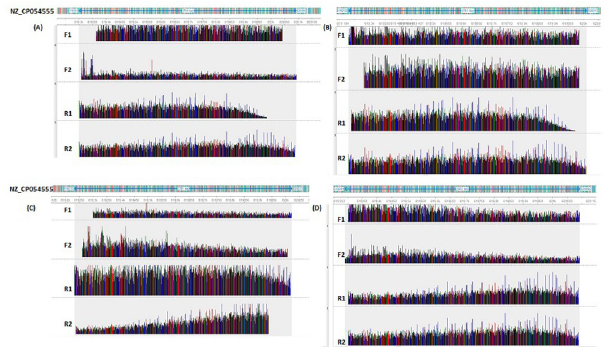
Fig 4. Sequence mapping. Images of mapping of sequence reads for 4 representative samples (sample 1, 7, 9 and 12) to the reference genome of Corynebacterium pseudotuberculosis (Accession number: NZ_CP054555.1). The sequence reads mapped to reference genome between positions 619301–620091 (791 bp), 619232–620012 (781 bp), 619233– 620023 (791 bp) and 619293–620093 (801 bp) for A (sample 1), B (sample 7), C (sample 9) and D (sample 12) respectively.